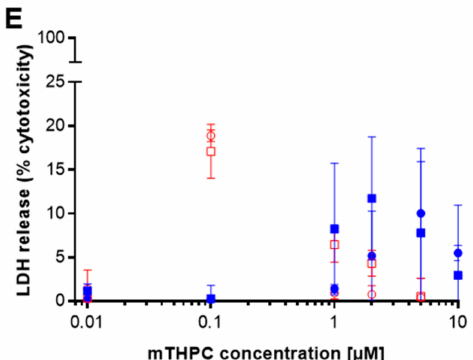
Figure 2. Dark ( (cid:8) , 6 h; (cid:4) , 24 h) and light-induced ( , 6 h; (cid:3) , 24 h) cytotoxicity after mTHPC-PDT (cid:35) as assessed by LDH release assay. The five cell lines A-427 ( A ), BHY ( B ), KYSE-70 ( C ), RT-4 ( D ), and SISO ( E ) were treated with mTHPC for 24 h in concentrations ranging from 0.01–10.0 µ M and kept in the dark (dark toxicity) or illuminated with a light dose of 1.8 J / cm 2 or 3.5 J / cm 2 (light-induced toxicity). LDH release assay was carried out 24 or 6 h post illumination, respectively, and the absorbance of the reduced INT was measured at λ = 490 nm. The percentage of cytotoxicity was calculated by dividing the absorbance for the treated group by the absorbance at maximum LDH release. Results are presented as means ± SD from at least three independent